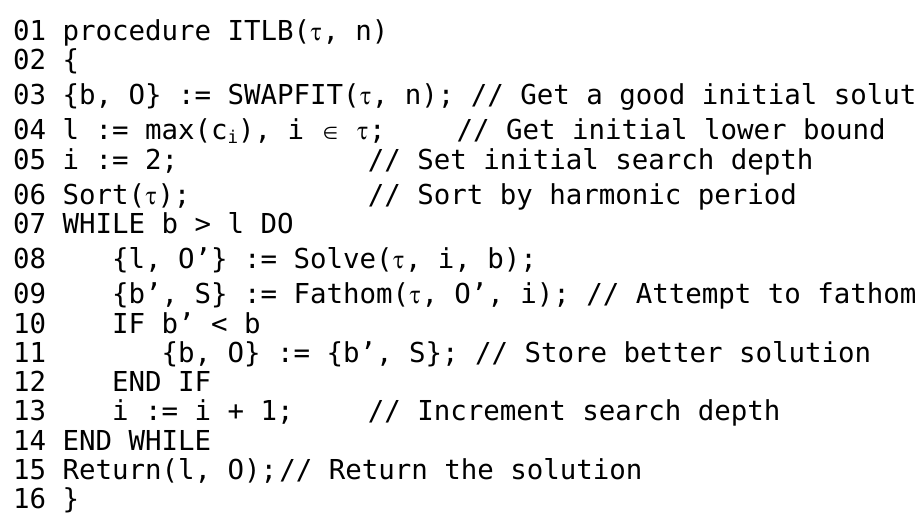
Figure 8. ITLB algorithm, in